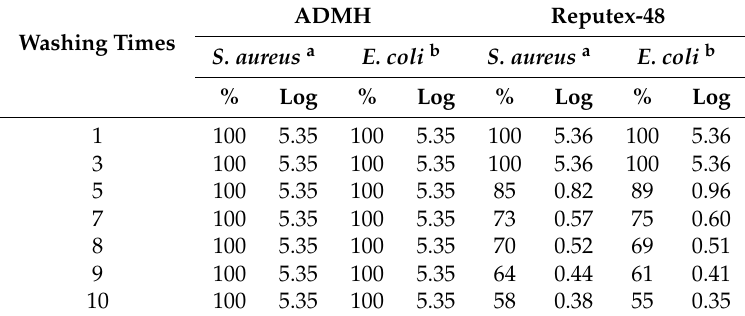
Table 4. Percentage and log reduction of S. aureus and E. coli after different washing times.